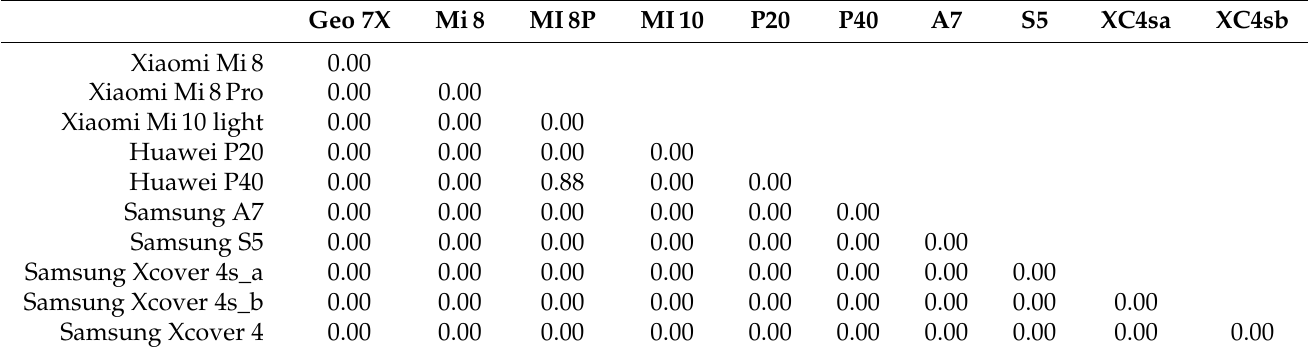
Table 5. Wilcoxon Rank Sum Test with continuity correction and ’holm’ correction between the absolute positioning errors of the studied smartphones ( p -values, α =